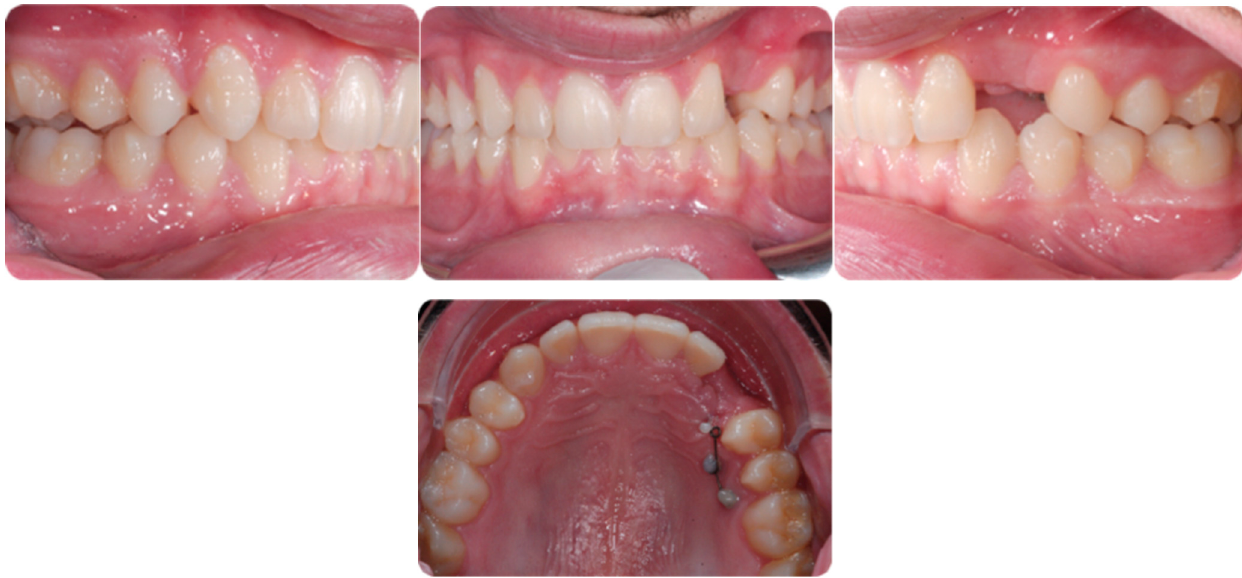
Figure 4. Initial orthodontic vertical traction on a 0-18 SS wire.